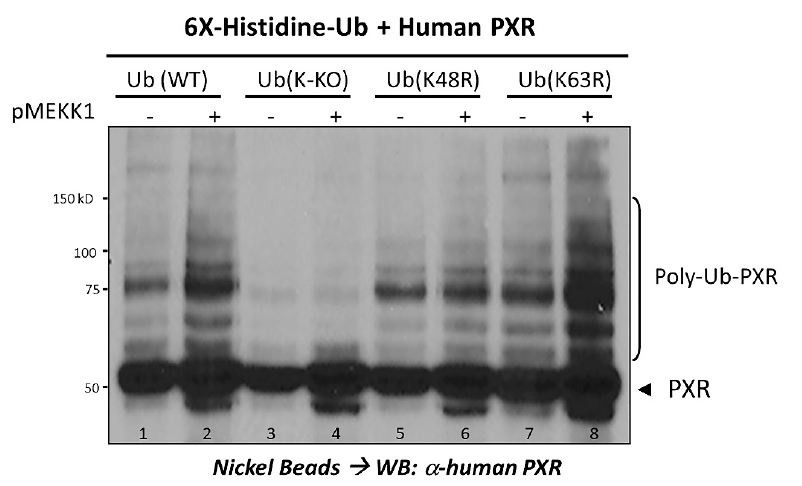
Figure 3. Poly-ubiquitination of the PXR protein is stimulated by the MEKK signaling pathway. The plasmid encoding the 6x-His-tagged ubiquitin protein and indicated mutant Ub expression vectors were co-transfected into HeLa cells with the expression vector encoding the PXR protein together with a constitutively active form of MEKK (a.a. 380–672), which activates JNK signaling cascade, as indicated. Total cell extract was subjected to purification using nickel-linked agarose beads, followed by SDS-PAGE and Western blotting using a monoclonal antibody against the human PXR protein (Santa Cruz,